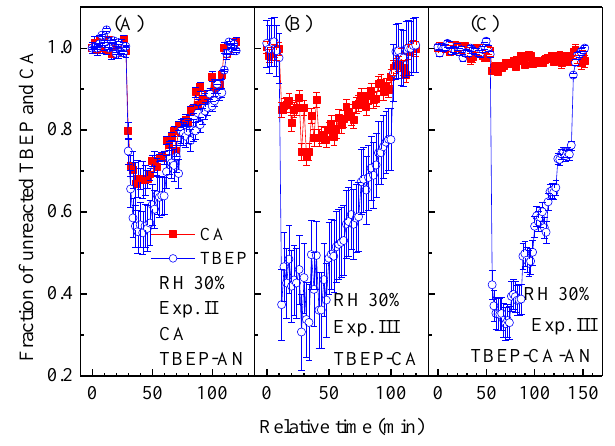
Figure 7. Comparison for the c /c 0 ratio of TBEP and CA in (a) ex- ternally mixed CA and TBEP-AN, (b) internally mixed TBEP-CA, and (c) internally mixed TBEP-CA-AN at 298K and (30 ± 3)%